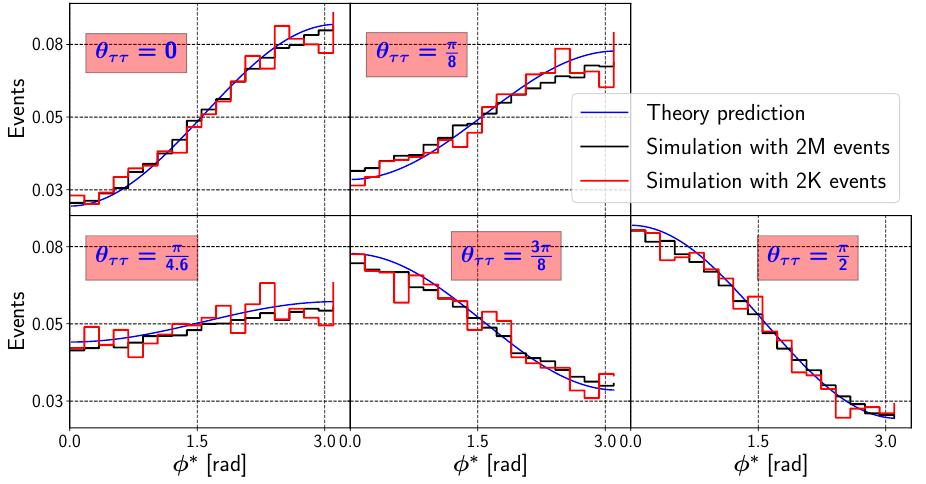
Figure 5 . Distributions for the events pp → H 2 → τ ¯ τ in the τ -acoplanarity angle φ ∗ , in the zero momentum frame, see section 2.4 for details. The red lines denote the results from a MonteCarlo simulation with MadGraph5 for the 2043 events, as expected for the chosen benchmark point at the HL-LHC. The black lines are evaluated from samples with 2M events and indicate the infinite statistics limit. Systematic uncertainties stem from hadronisation, detector simulation, and reconstruction. The blue lines were derived from the theory prediction in eq. (2.16). For all distributions the total number of events is normalised to